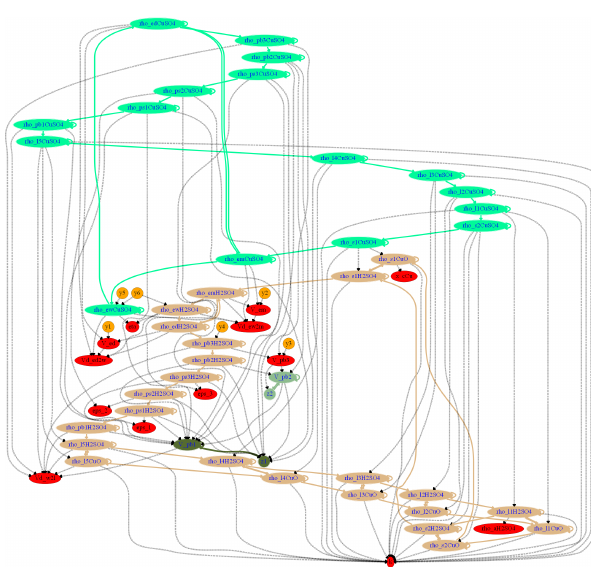
Figure 3: System